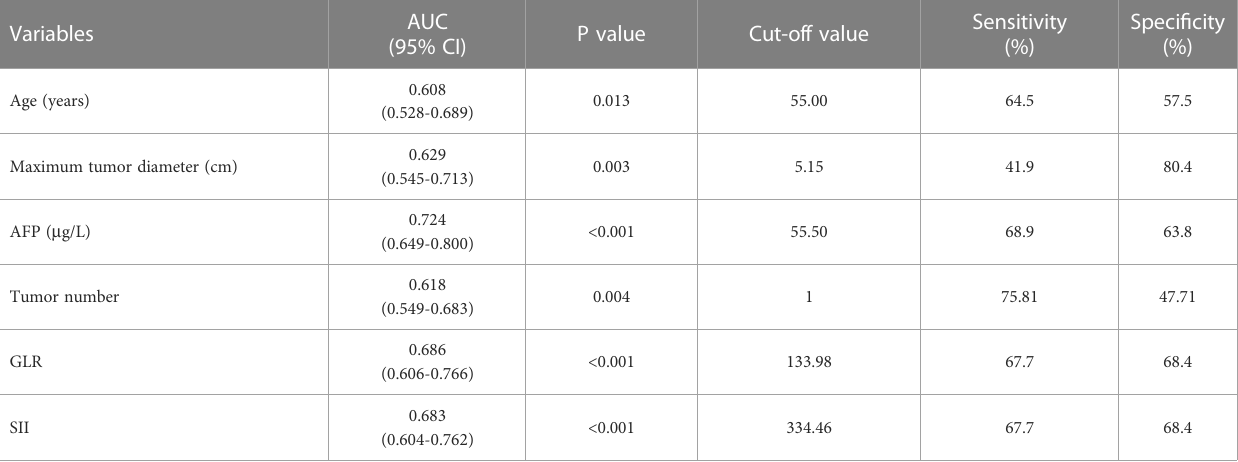
TABLE 2 The area under curve and cut-off value of